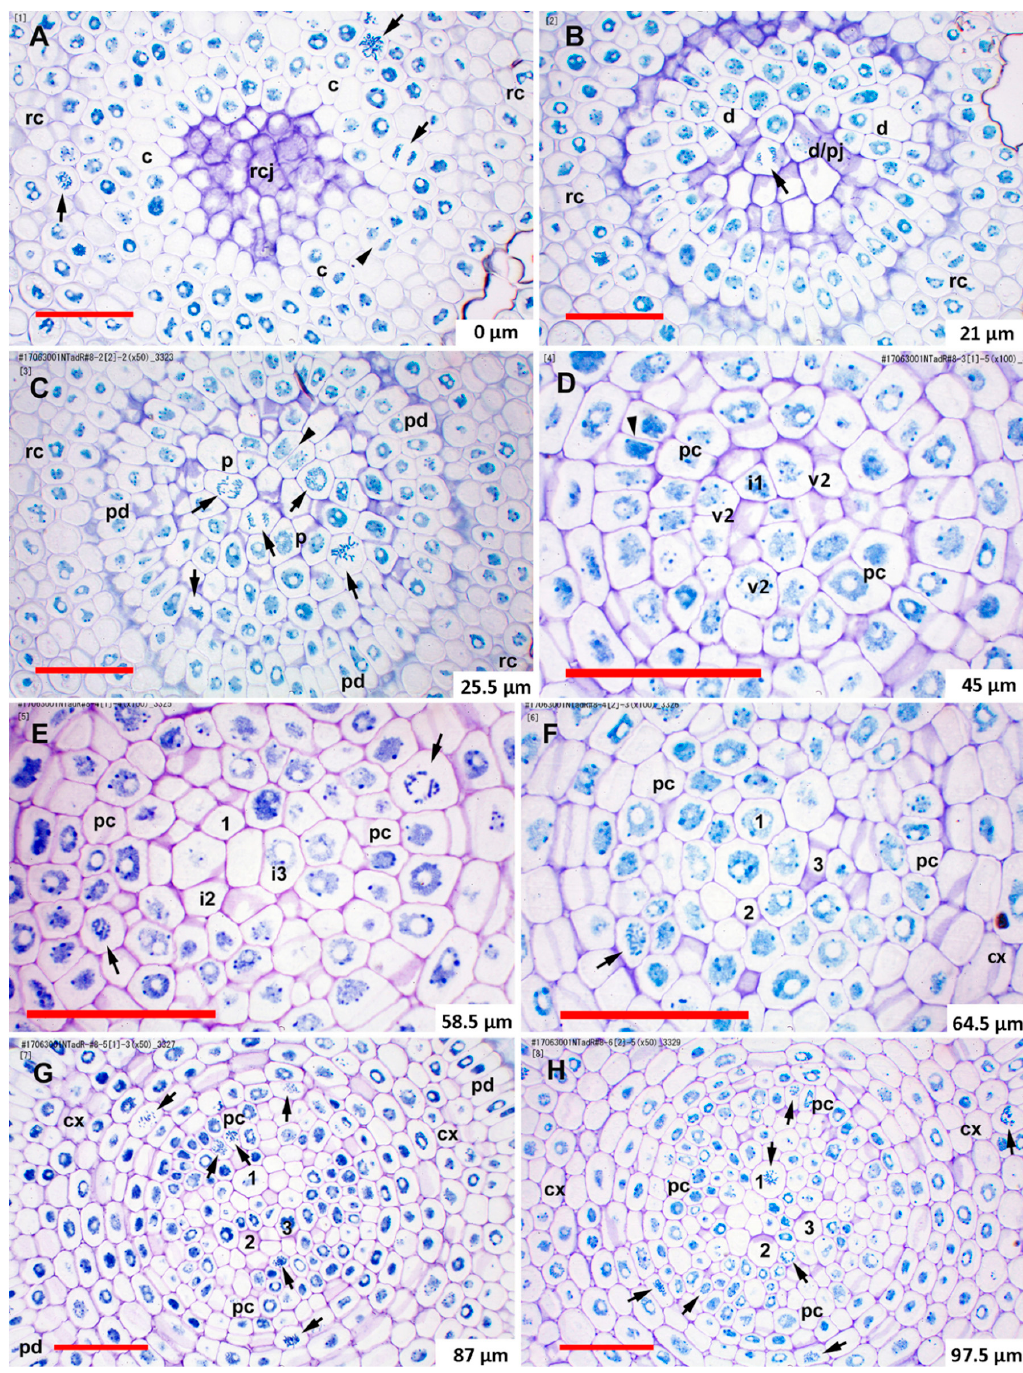
Figure 2. RNase-treated transverse sections featuring the histogens and procambium of a typical teosinte root tip taken during a rare period of mitotic activity in its quiescent center that also show the pattern of late-maturing metaxylem vessel (LMX) initiation and xylem tissue development. ( A ) The root cap junction (RCJ) cell walls are at center, acropetal view (toward the root cap); designated the 0 µm reference. Cells of the calyptrogen and root cap predominate. The acropetal end of a dermatogen-periblem central cell is visible at the center. ( B ). The dermatogen-perbilem complex/plerome junction (d/pj) 21 µm from the RCJ. The indicated mitotic cell is the plerome central cell. ( C ). Mitotically active plerome within an area normally reported to be mitotically “quiescent” 25.5 µm from RCJ. ( D ). Section through the 2nd vascular initials layer (v2) 45 µm from RCJ that includes the initial for the first LMX (i1). Transverse cell walls separating the two layers of vascular initials are present at center. ( E ). Section 58.5 µ m from RCJ. Two more LMX initials are present (i2 and i3). The most acropetal cell of the first LMX file is at 1. ( F ).